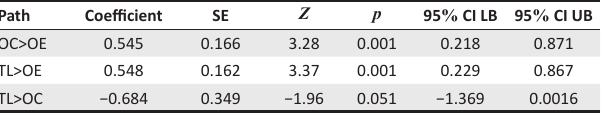
TABLE 5: Direct effects between different paths.